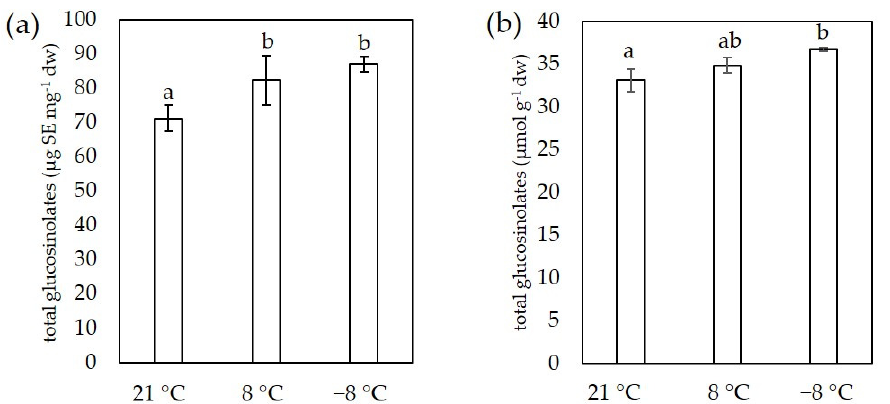
Figure 4. Total glucosinolates content measured spectrophotometrically ( a ) and by HPLC-DAD ( b ) in flat leaf kale sprouts ( B. oleracea var. acephala ) affected by different temperatures. Value marked with different letters are significantly different at p < 0.05.